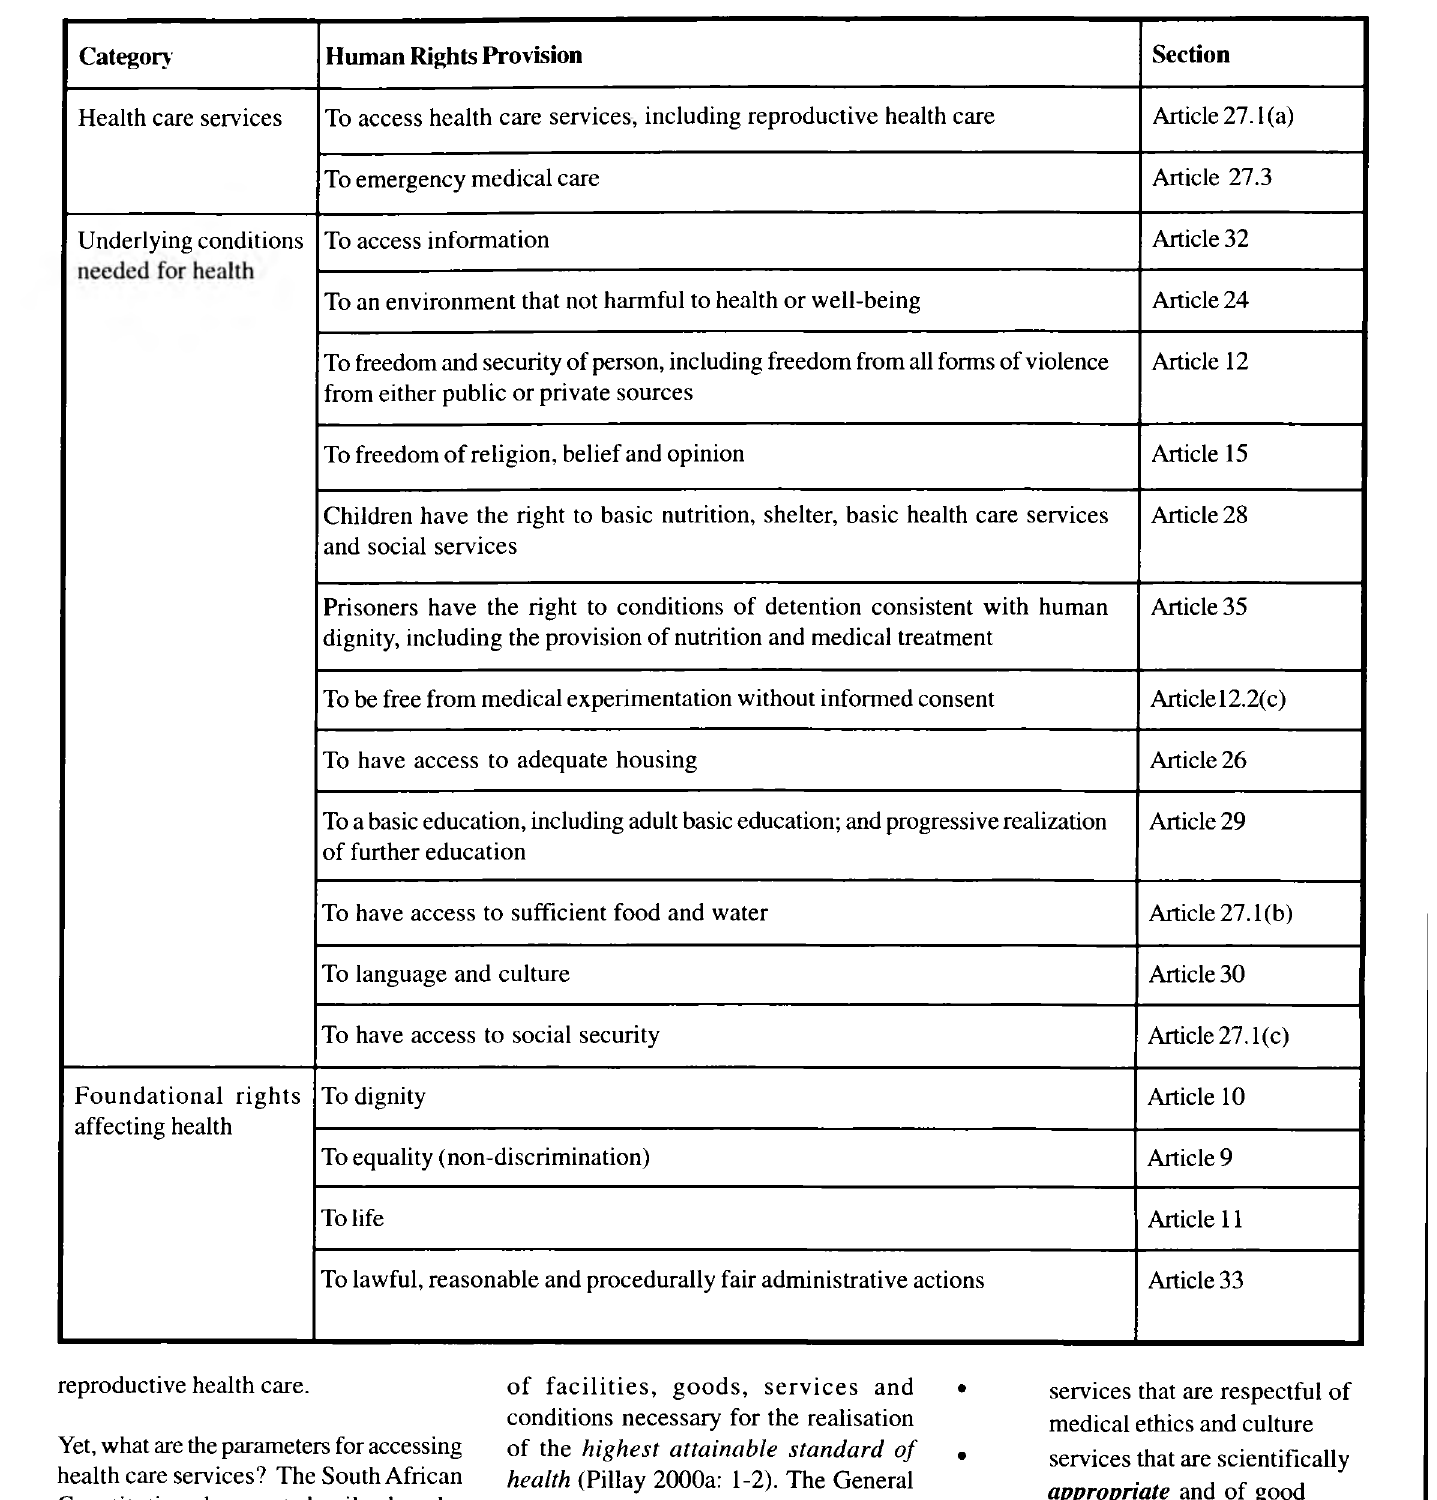
Table 1. Categories of Health Rights in the South African Constitution